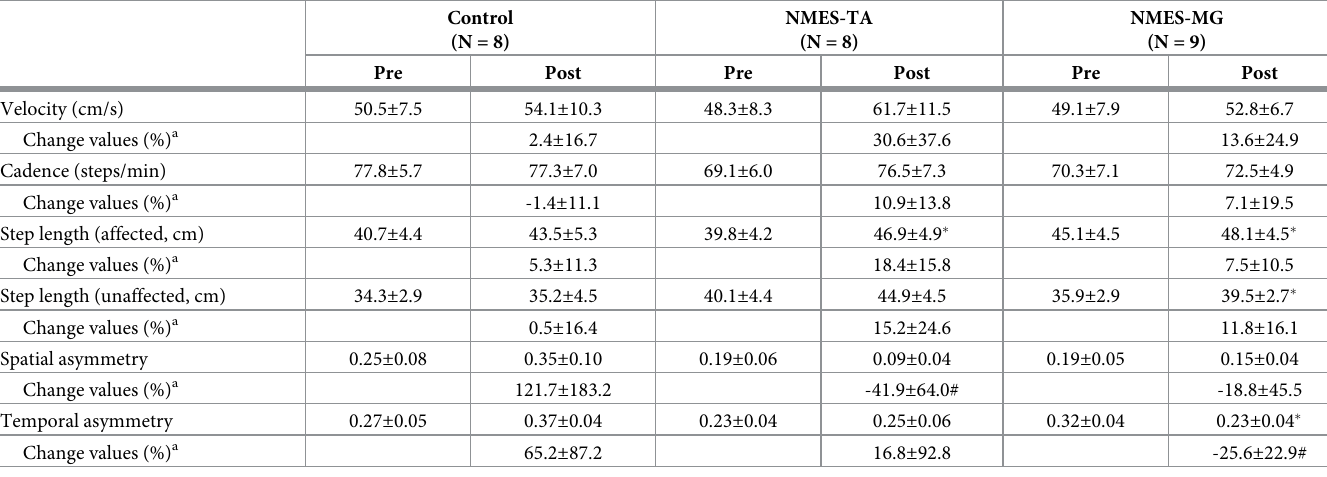
Table 3. Gait performance before and after training in 3 groups.